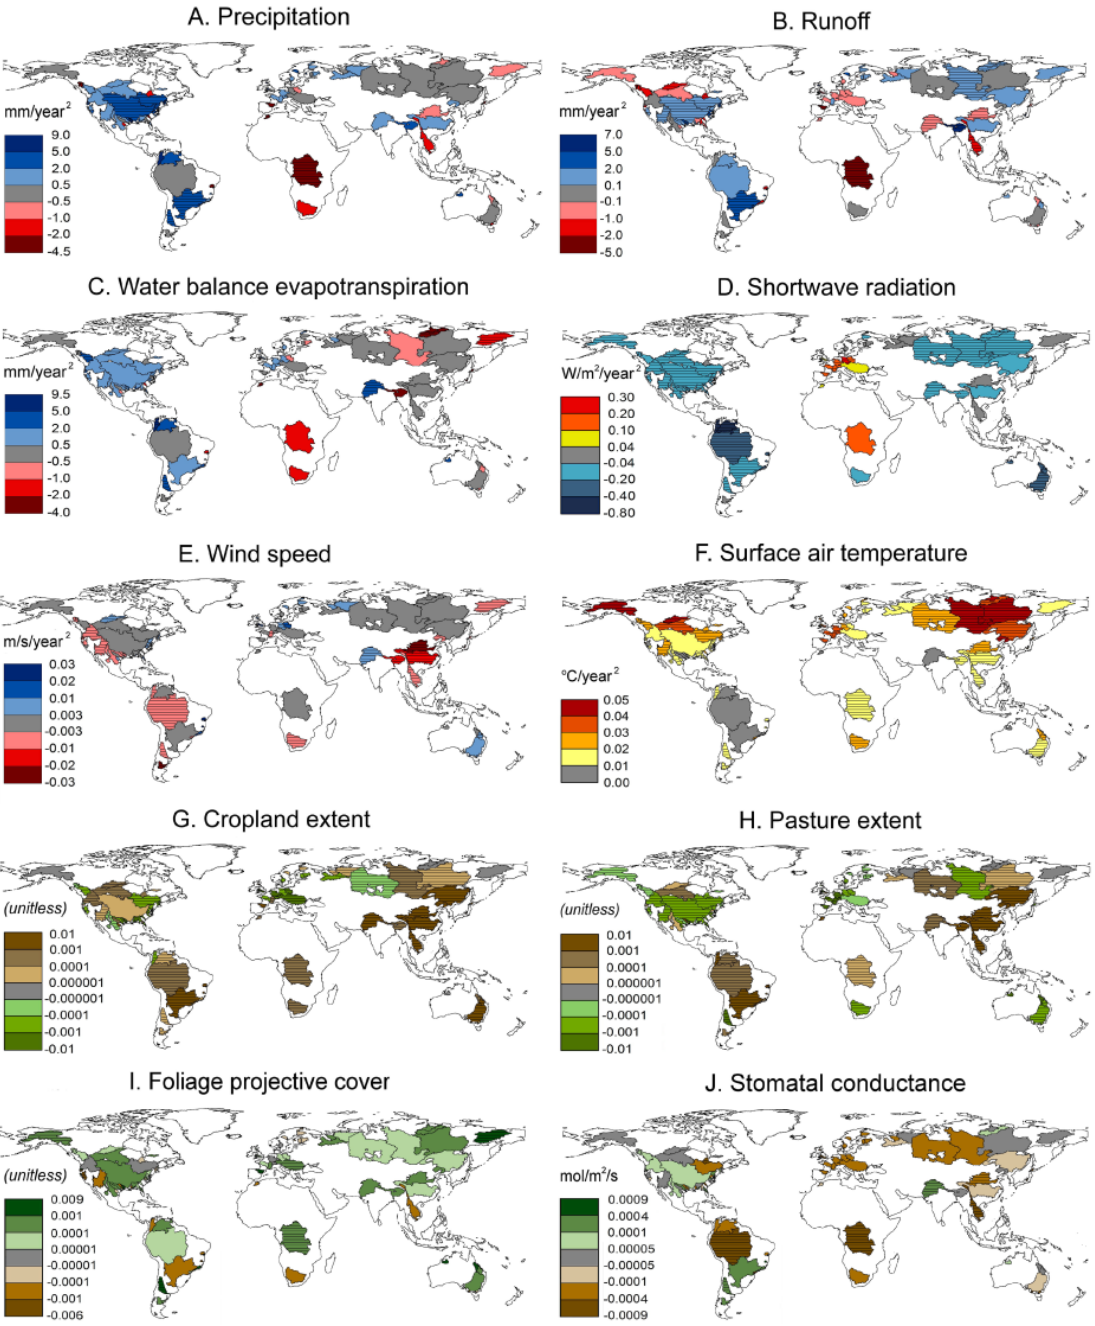
Fig. 5. Trends in observed CRU TS 3.1 precipitation, runoff, CRU-based water balance ET, solar radiation, wind speed, air temperature and land cover, and modelled stomatal conductance and foliage cover. Basins with significant trends are shown